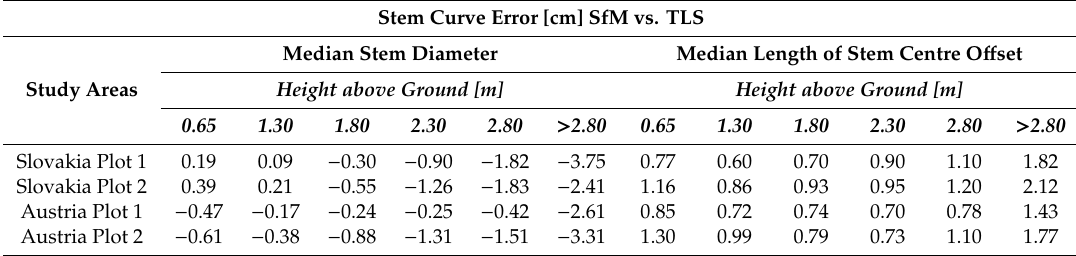
Table A2. Median SfM stem curve